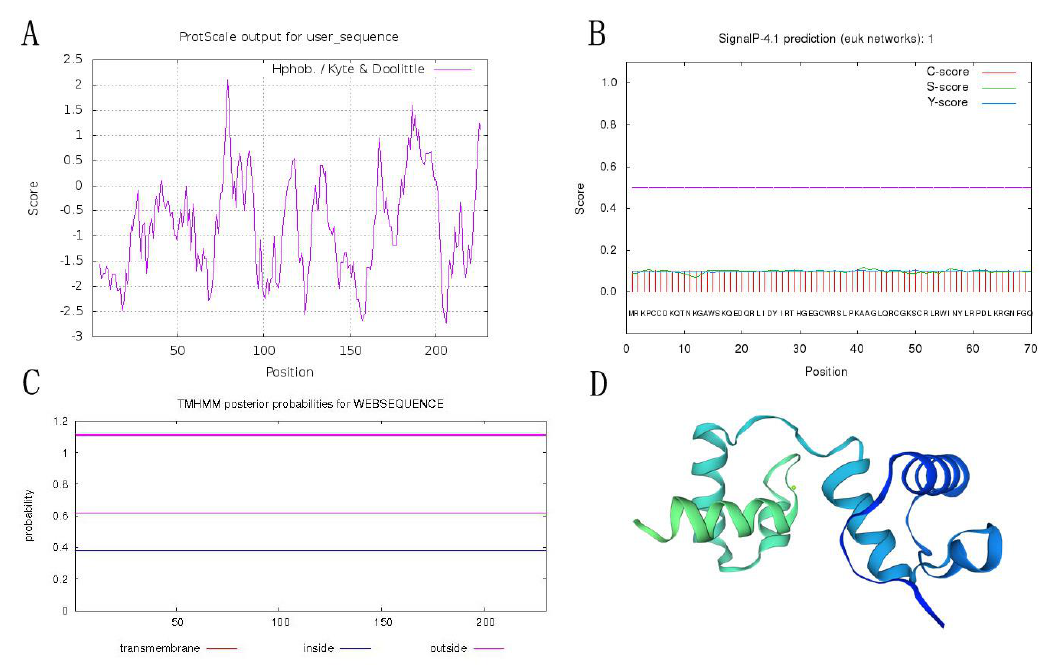
Figure 2. Bioinformatics analysis of PqMYB4 protein. ( A ) hydrophilic and hydrophobic analysis; ( B ) signal peptide analysis; ( C ) transmembrane analysis; ( D ) tertiary structure prediction.